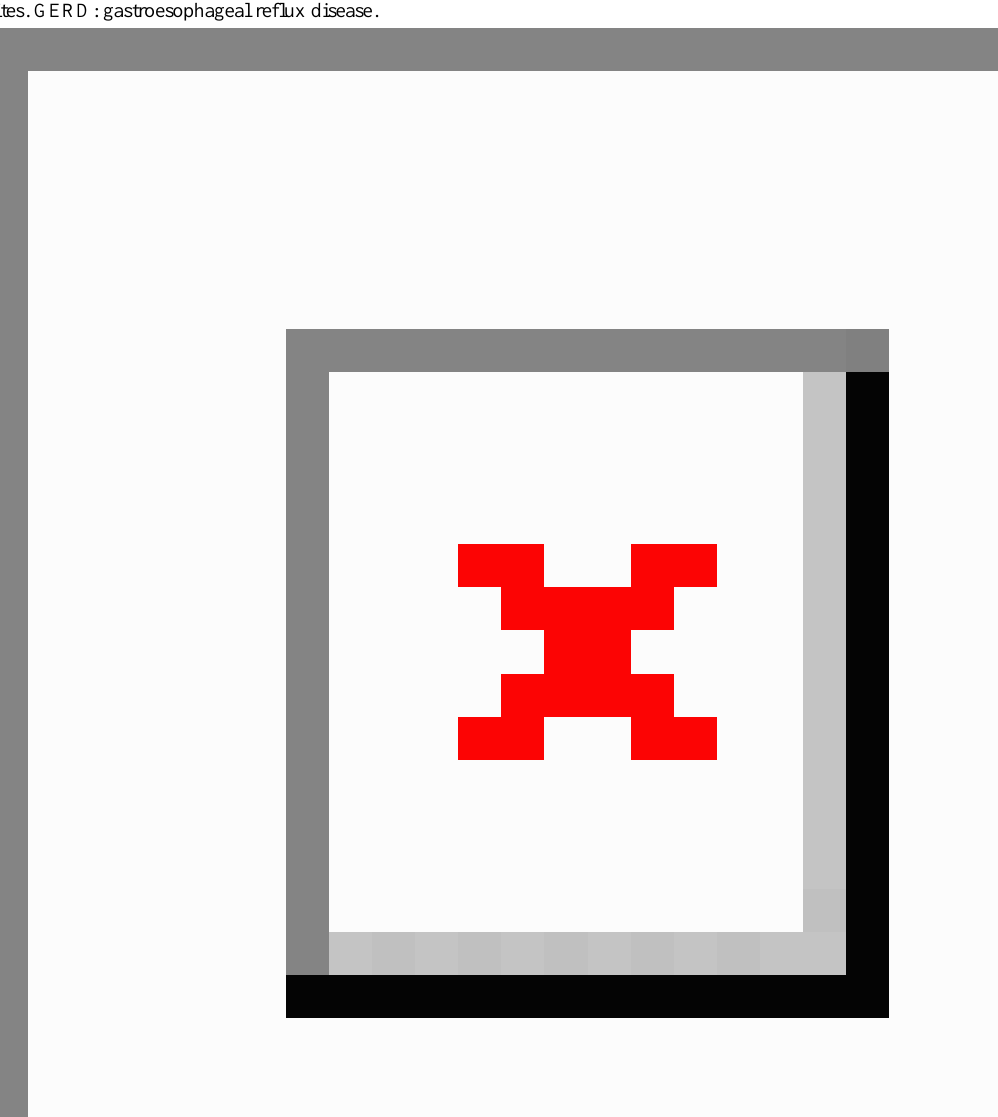
Figure 4. Heatmap presenting the results of the hierarchical clustering of web users on the basis of the discussed topics, symptoms, and activity on websites. GERD: gastroesophageal reflux disease.